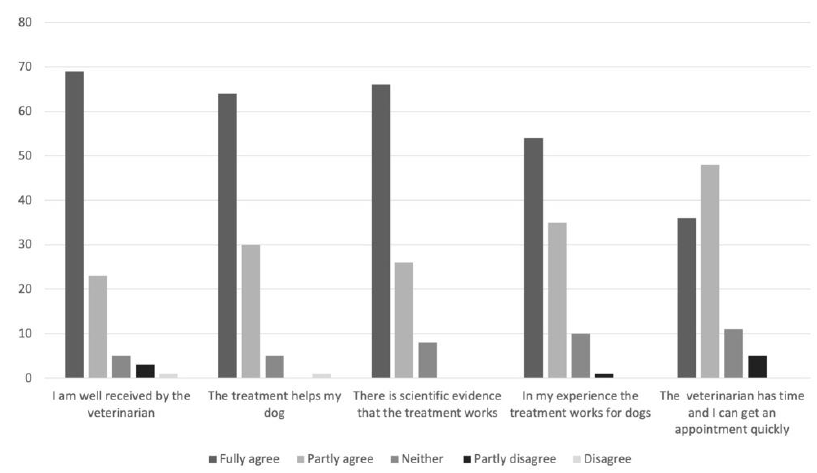
Figure 2. Responses by Swedish dog owners ( n = 100) to the question “If you have consulted a veterinarian when your dog was sick or injured, why?”.